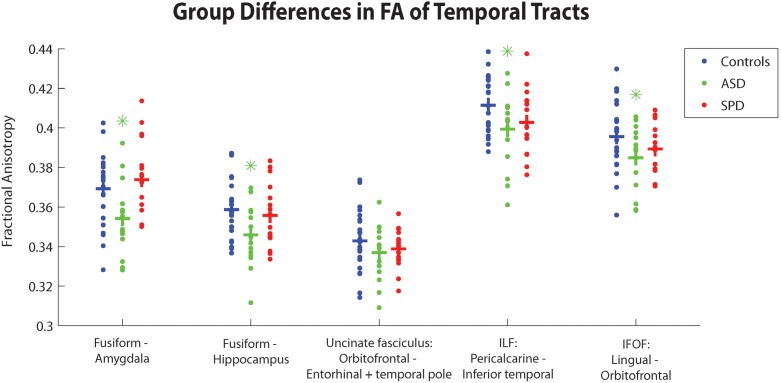
Group differences between TDC, SPD, and ASD subjects in average FA within different temporal tracts.Crossbars correspond to group averages. Green asterisks depict significant group differences between ASD and TDC subjects, and red asterisks depict significant group differences between SPD and TDC subjects, FDR corrected at p<0.05.